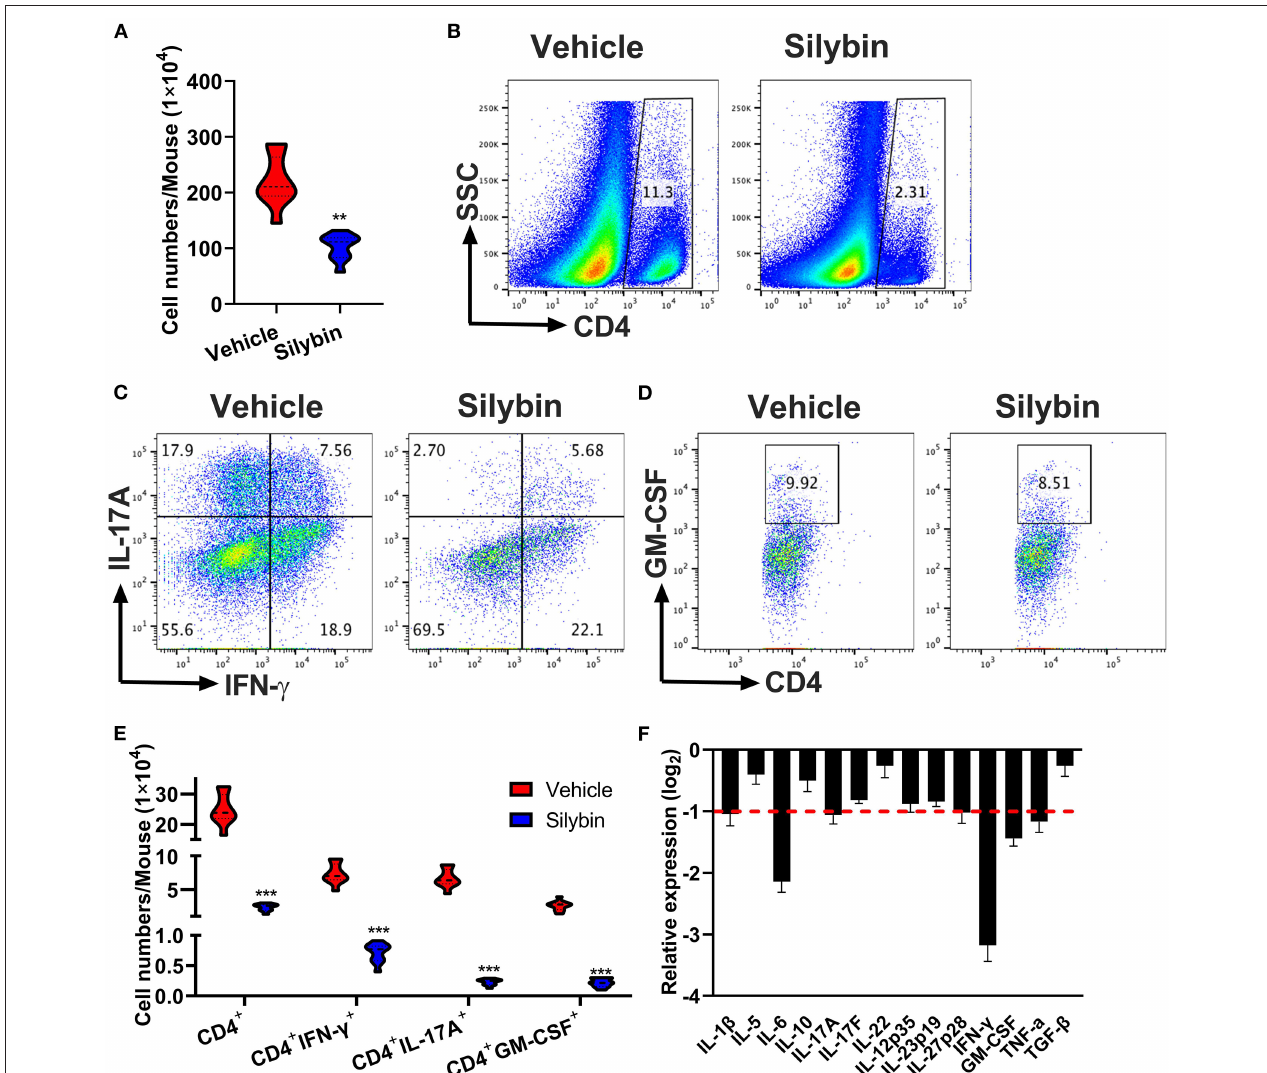
FIGURE 4 | Silybin therapeutic blocked inflammatory infiltration in the central nervous system (CNS). Mice were treated with vehicle or silybin at the day of experimental autoimmune encephalomyelitis (EAE) induction and sacrificed at day 21 p.i. Spinal cords and brain were collected and mononuclear cells (MNCs) separated ( n = 5 each group). (A) Total MNC numbers in CNS were counted by a light microscope. (B) The percentage of CD4 + T cells was measured by flow cytometry. (C,D) Frequencies of IFN- γ + , IL-17A + , and GM-CSF + cells among CD4 + cells were assessed by flow cytometry. (E) Absolute numbers of infiltrated CD4 + T and Th subsets were calculated by multiplying the percentages of these cells with total numbers of MNCs in each CNS tissue. (F) The expression of cytokine genes was determined using real-time RT-PCR analysis, and their relative expression was calculated by log 2 of – 11 Ct values from triplicate of PCR. More than two-fold changes (log 2 < − 1) were considered significant between groups (red dotted line). Symbols represent mean ± SD ( n = 5 each group). ** p < 0.01 and *** p < 0.001. Student’s t -test. One representative of three independent experiments is